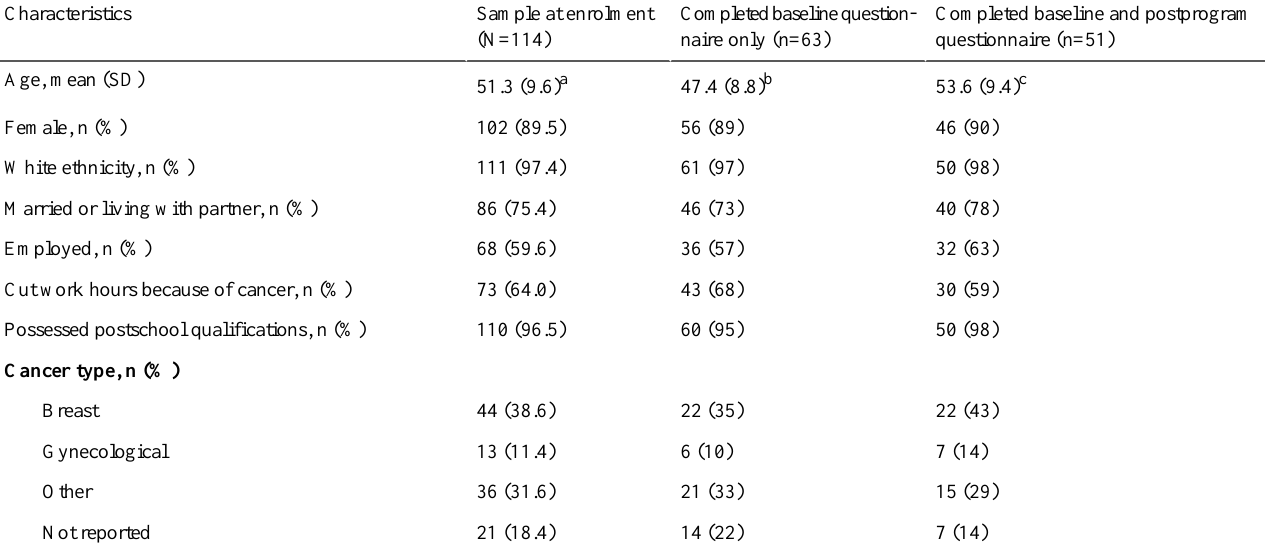
Table 2. Participant demographic information at enrolment, baseline, and